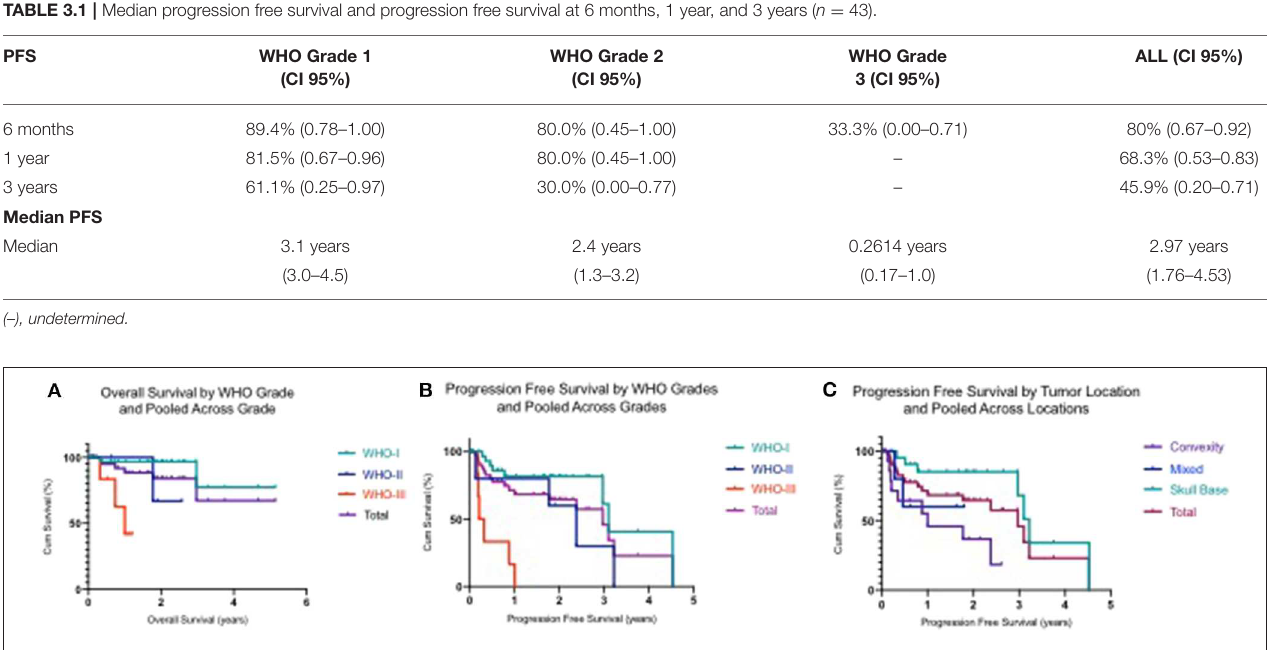
FIGURE 1 | (A) Kaplan–Meier plot demonstrating overall survival by WHO tumor grades and polled across WHO grades. (B) Kaplan–Meier plot demonstrating progression free survival by WHO tumor grades and polled across WHO grades. (C) Kaplan–Meier plot demonstrating progression free survival by tumor location and polled across